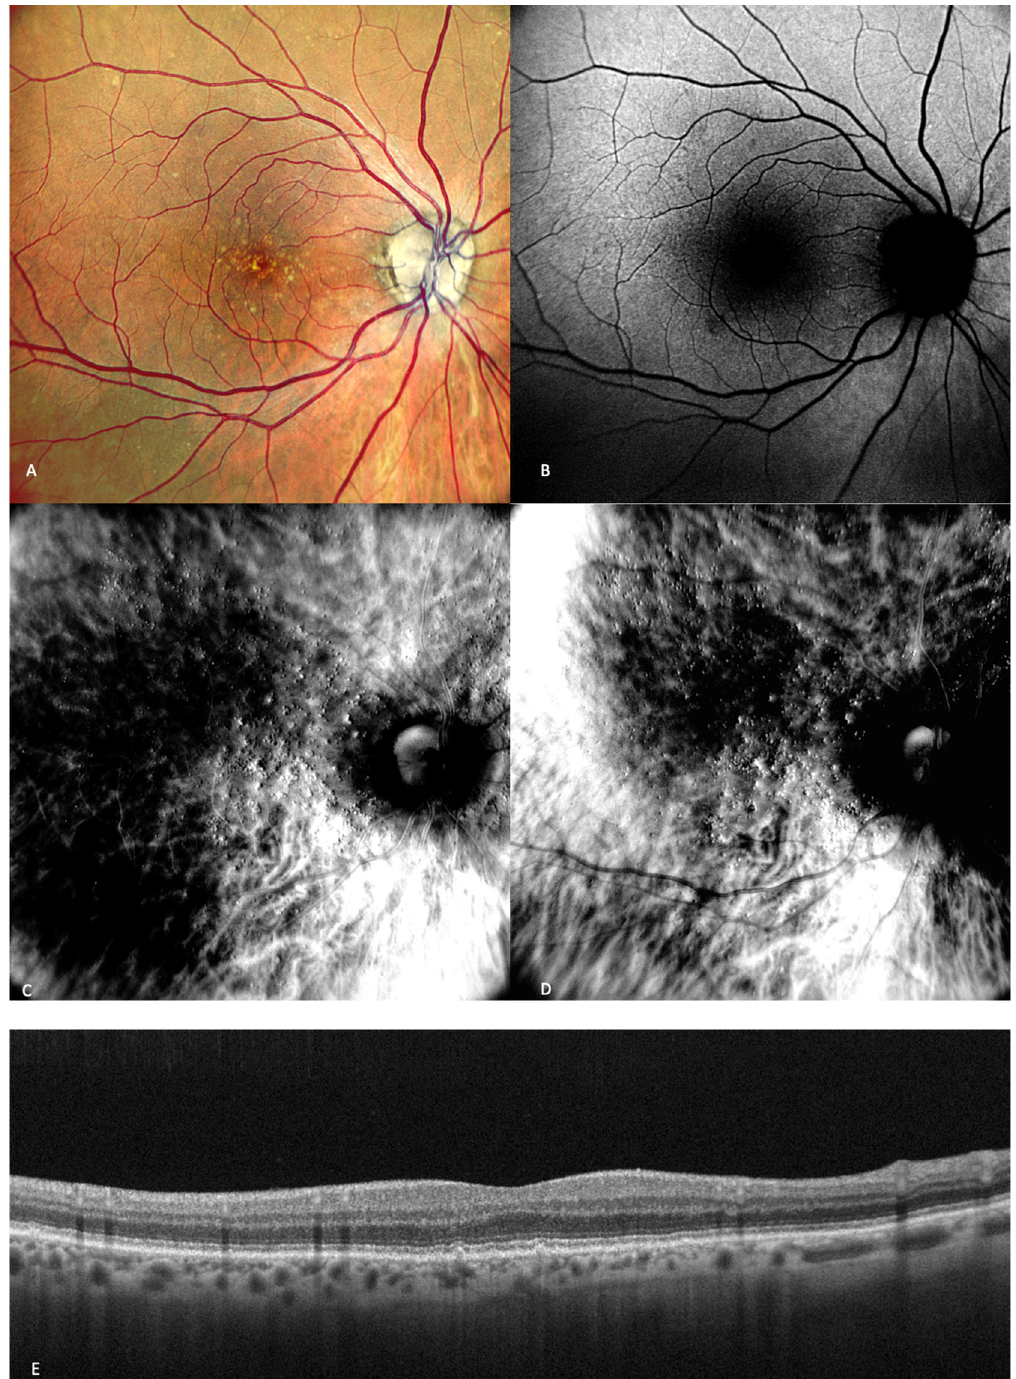
Figure 2. Early AMD. Multimodal imaging of small and medium drusen. ( A ) Color scanning laser ophthalmoscope photography shows multiple small drusenoid round, yellow deposits. ( B ) On the fundus autofluorescence, drusen hardly cause any effect. ( C ) Retromode deviated to right and ( D ) retromode deviated to left display drusen as small elevations or depressions, respectively. Drusen number and extension are obviously more easily visualized on the retromode images than on the cSLO image. ( E ) SD-OCT section, which shows drusen as small elevations of the RPE.